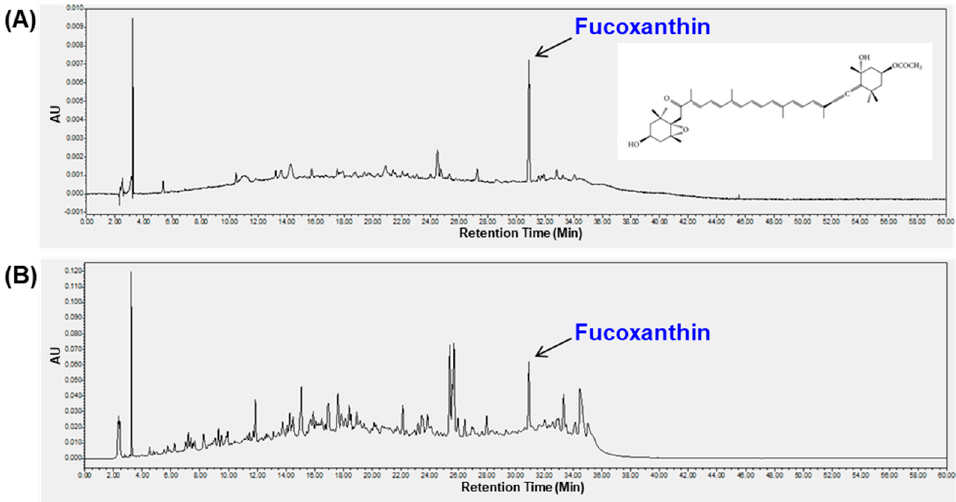
Figure 6. High-performance liquid chromatography (HPLC) chromatograms of ( A ) the fucoxanthin standard ( B ) EtOAc fraction of L. difformis EtOH extract (LDE-EA). AU indicates the absorbance unit.